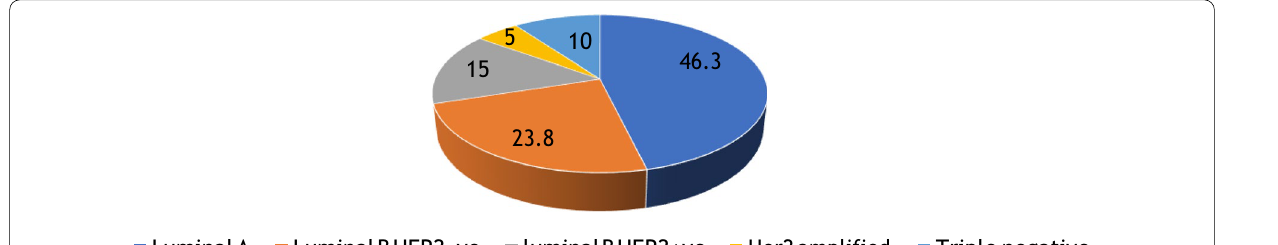
Fig. 1 Distribution of molecular subtypes among the study